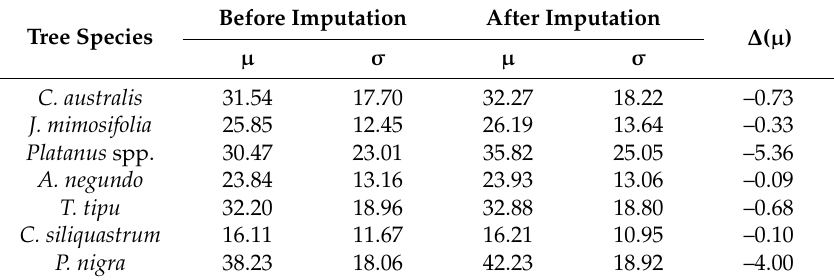
Table 5. Mean ( µ ) and standard deviation ( σ ) for dbh (cm) before and after imputation of missing values, along with the difference between before and after imputation means.